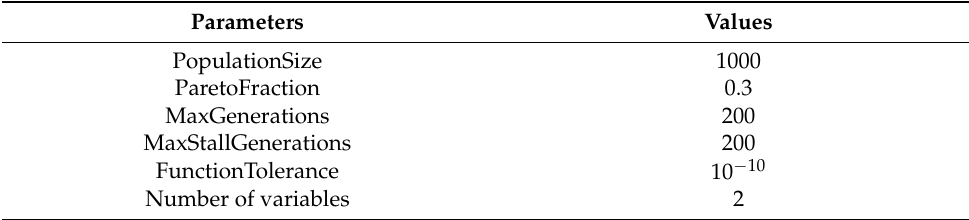
Table 3. GAMULTIOBJ function parameters. Parameters Values PopulationSize